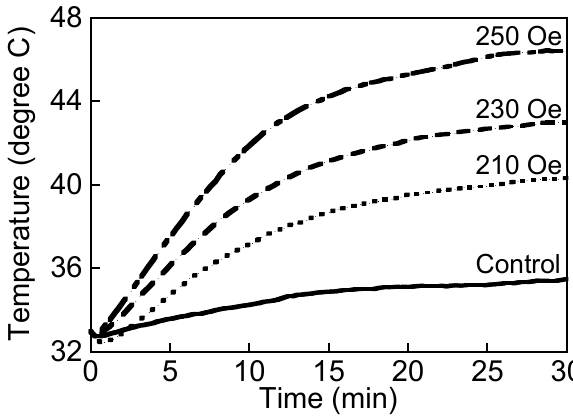
Figure 6. The temperature rise of culture medium added with PEI-coated MNPs of 200 μ g/mL in the case of applying an AC magnetic field for 30 min. The magnetic field intensity was 210, 230 and 250 Oe. The frequency of magnetic field was 210 kHz. The control indicates the sample added with nothing in the case of applying the AC magnetic field of 250 Oe. MNPs were effective in hyperthermia. The temperature rise depended on AC magnetic field intensity.